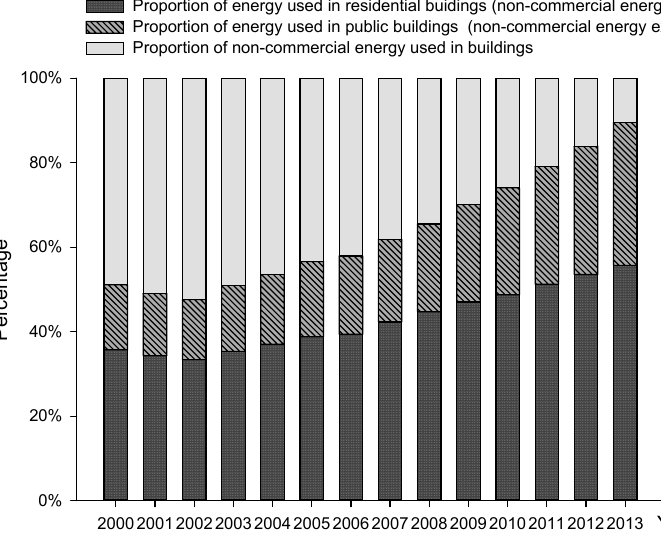
Figure 9. Energy consumption of buildings and its proportion in China